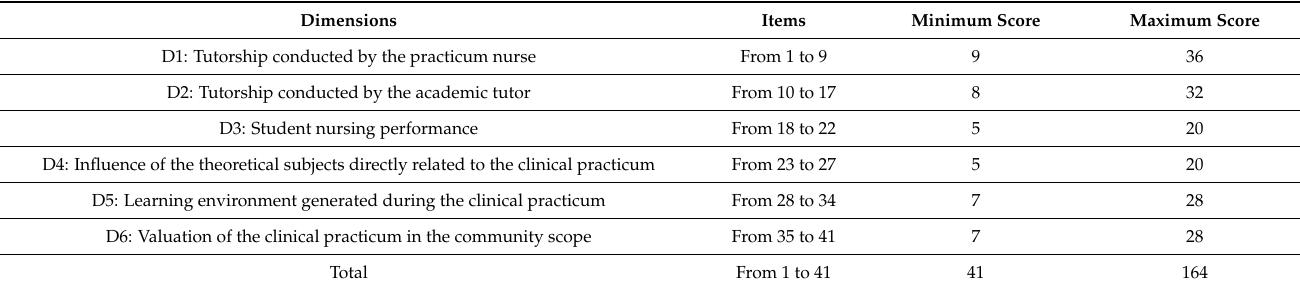
Table 1. Distribution, by category, of the evaluation questionnaire items for the learning of the clinical practicum, and minimum and maximum values for each item and for the questionnaire